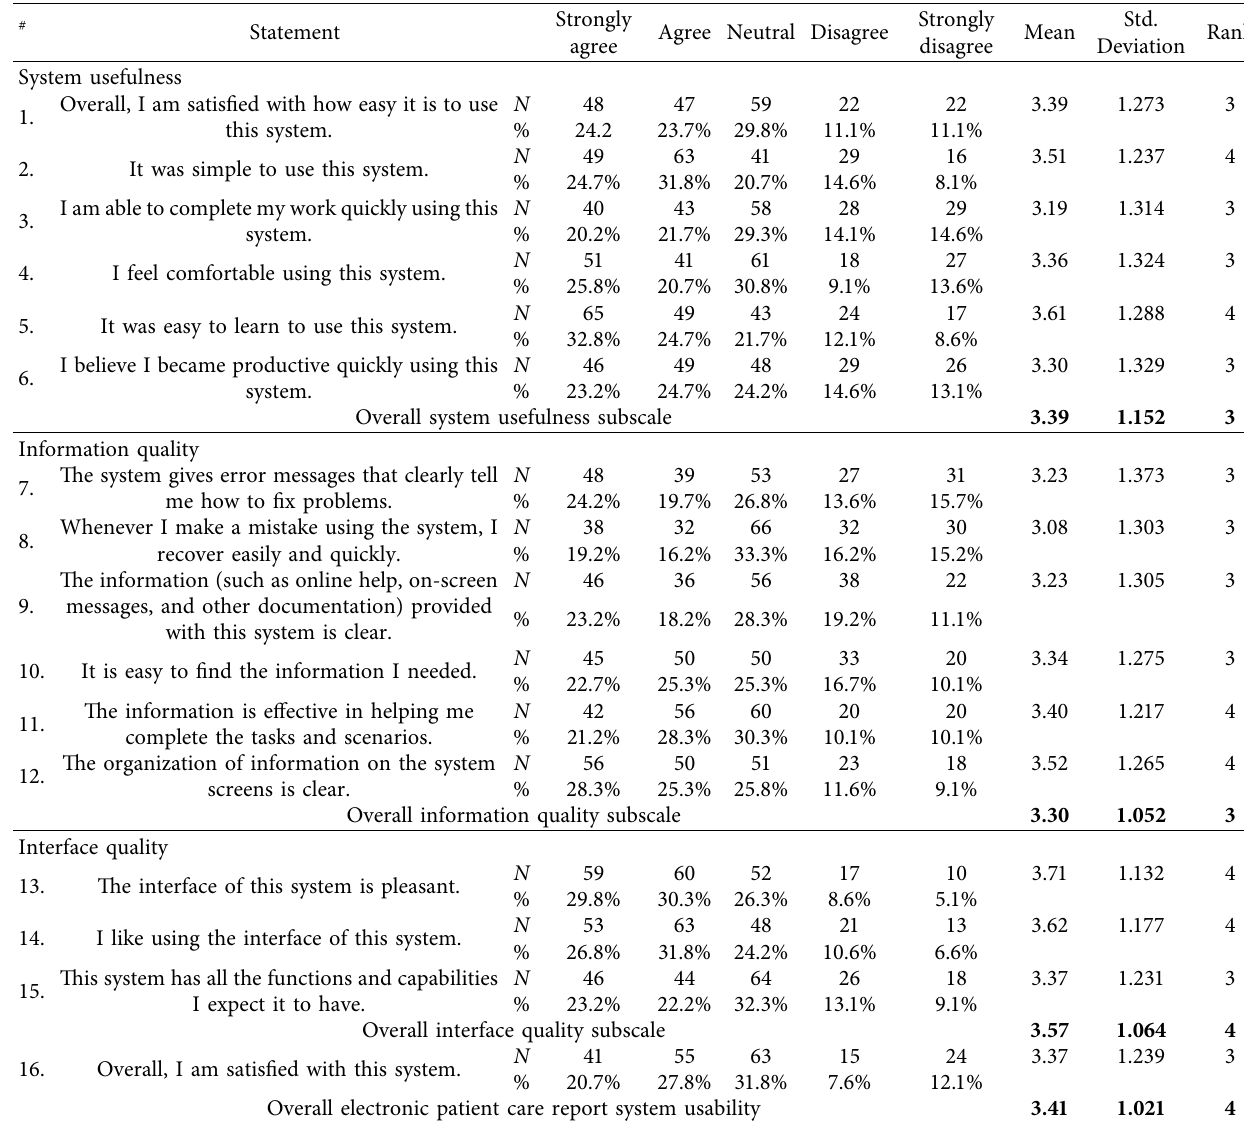
Table 3: Descriptive statistics for electronic patient care report system